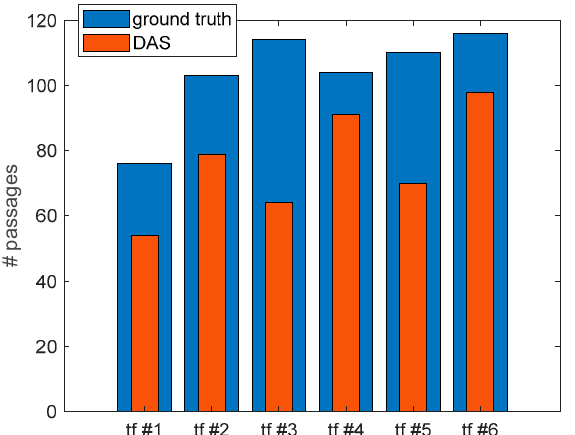
Figure 17. Number of actual (blue bars) and HT-detected (red bars) vehicle passages for each time frame of 10 min (from Ref. [144]).